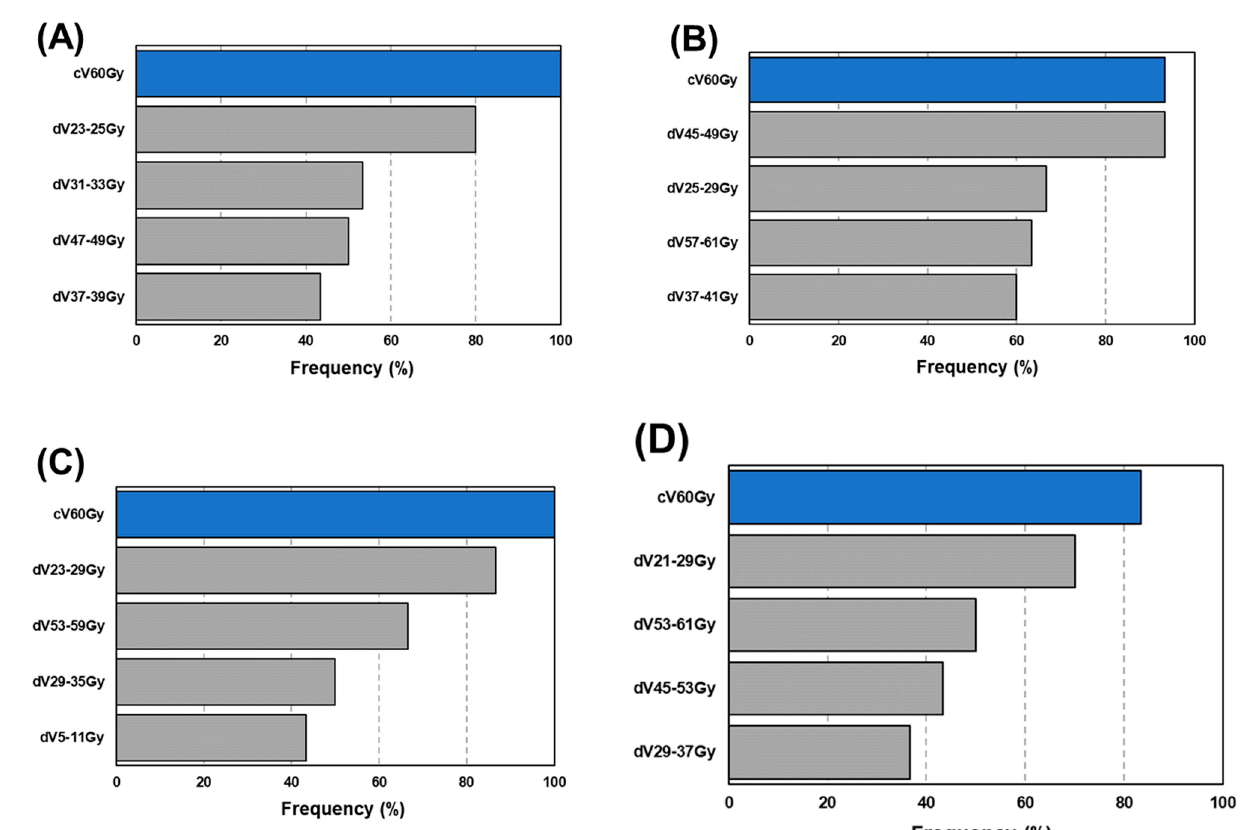
Figure 5. Frequently selected features in the developed model integrating cDVH and dDVH features with dose bin = 2 Gy ( A ), 4 Gy ( B ), 6 Gy ( C ), and 8 Gy ( D ). Abbreviations: cDVH = cumulative dose − volume histogram; dDVH = differential dose − volume histogram.